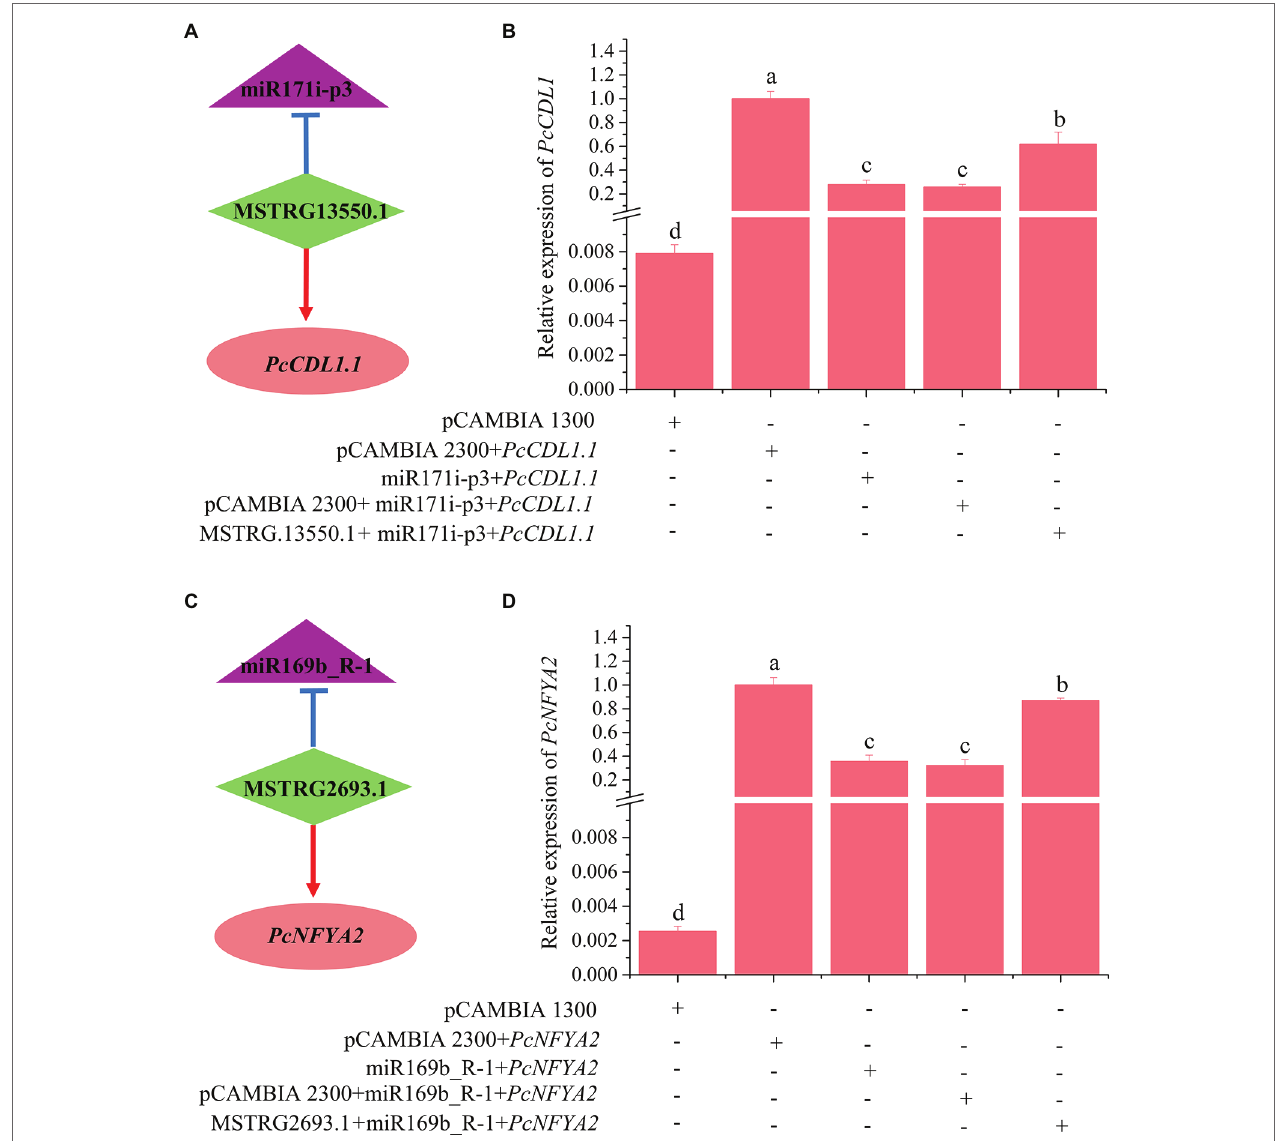
FIGURE 8 | Validation of 1ncRNA-miRNA-mRNA pairs using Nicotiana benthamiana leaves transient coexpression system by RT—qPCR (B,D) . The bars show the mean ± SE (n = 4). Different letters on the error bars indicate significant differences. (A) , MSTRG.13550.1 targets miR171i-p3 and acts as an eTM for miR171i-p3; (C) , MSTRG2693.1 targets miR169b R-1 and acts as an eTM for miR169b